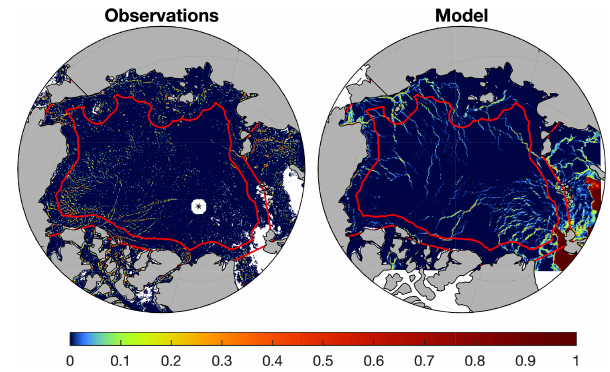
Figure 1. Observed and simulated daily mean lead fraction on 14 March 2007. The figure shows the entire model domain, and the red lines indicate the boundaries of the Arctic (outer region) and Central Arctic regions used in the study. Figure 2. The probability density function of observed and simu- lated lead fraction in the Central Arctic areas over JFM 2007. The dashed black lines are linear fits discussed in the